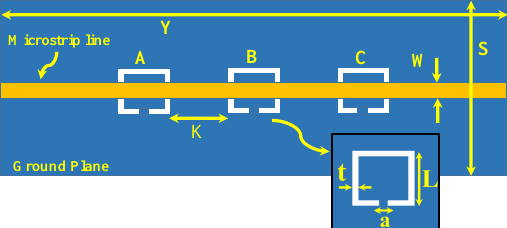
Figure 1. A two-port microstrip line exciting three identical complementary split-ring resonators (CSRRs) (A, B, and C) that are etched out in the ground plane of a microstrip transmission